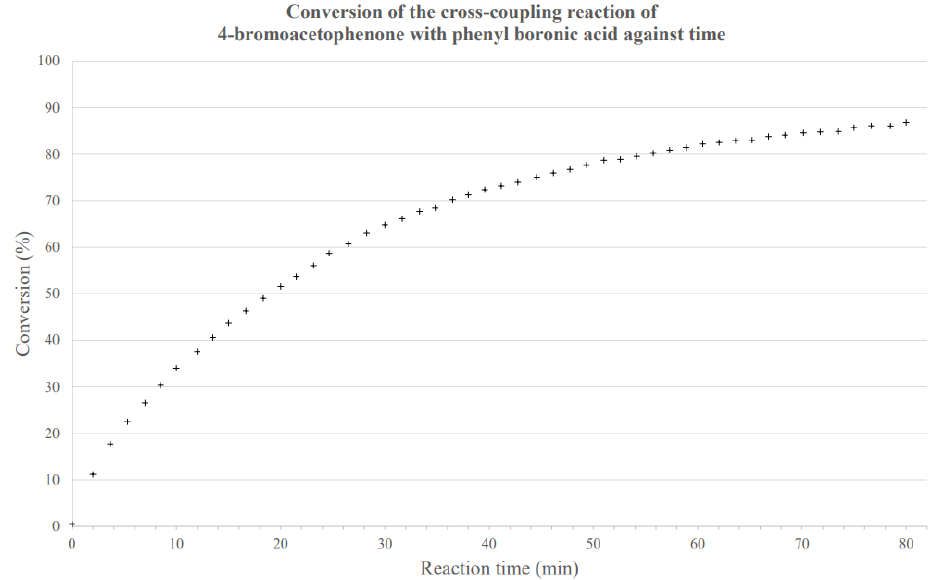
Figure 3. Reaction profile for the NMR conversion of the cross-coupling reaction of 4 – bromoaceto- phenone with phenyl boronic acid against time.